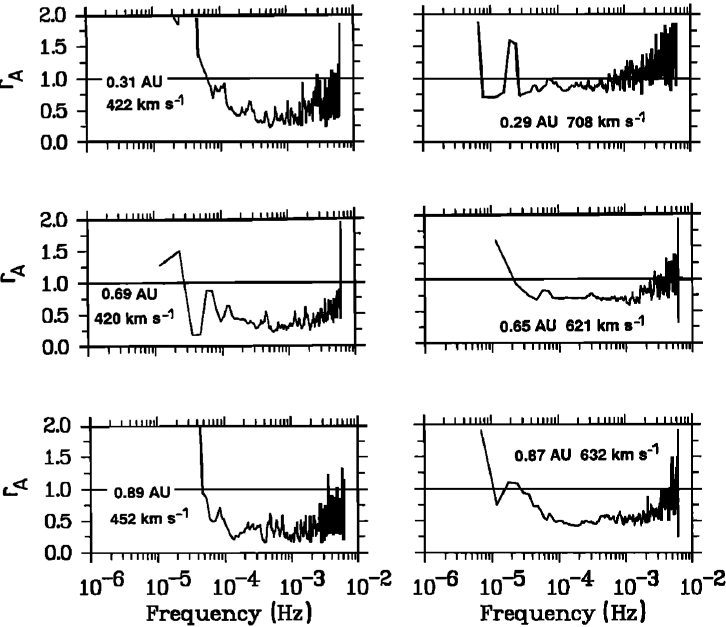
Figure 39: Values of the Alfv´en ratio 𝑟 A as a function of frequency and heliocentric distance, within slow (left column) and fast (right column) wind. Image reproduced by permission from Marsch and Tu (1990a), copyright by